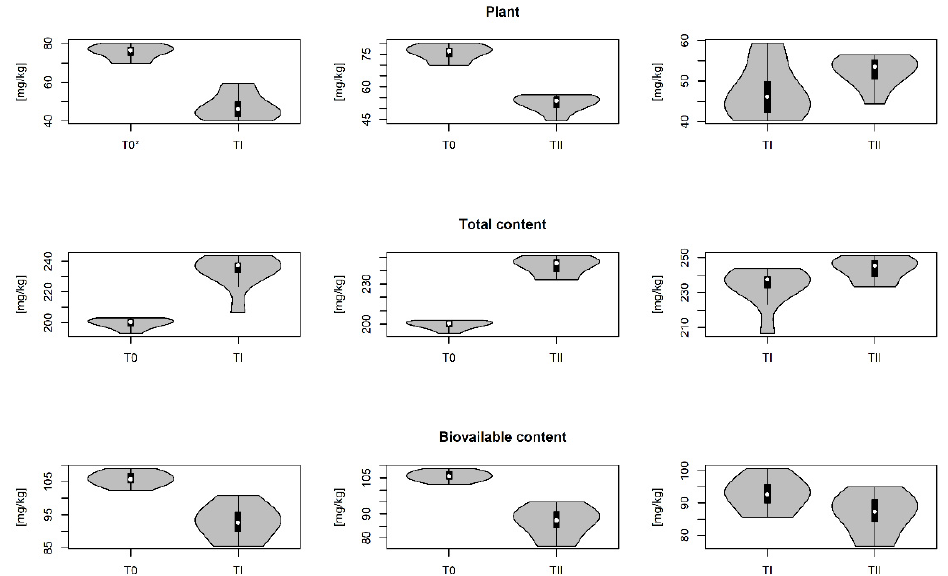
Figure 1. Cu contents in camelina and soil (total and bioavailable amounts) * descriptions see at Material and Methods, statistically significant differences and p -value are presented in Table 2.